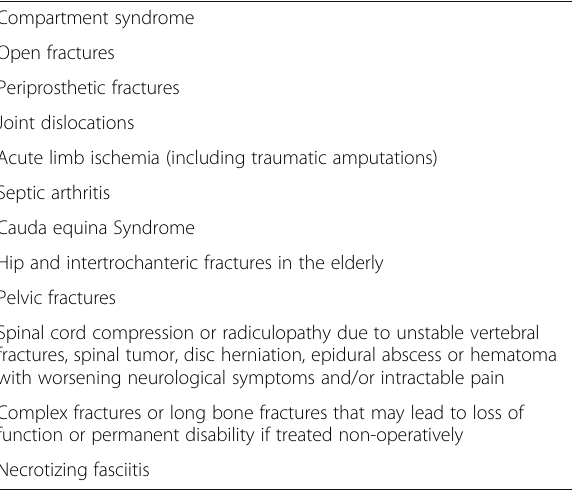
Table 1 Orthopaedic conditions needing urgent care [4, 11, 15, 16, 19, 23, 31, 36, 42, 46,